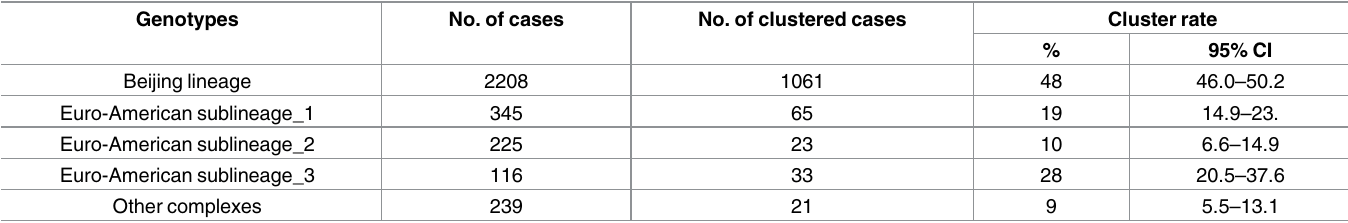
Table 4. Cluster rate in different